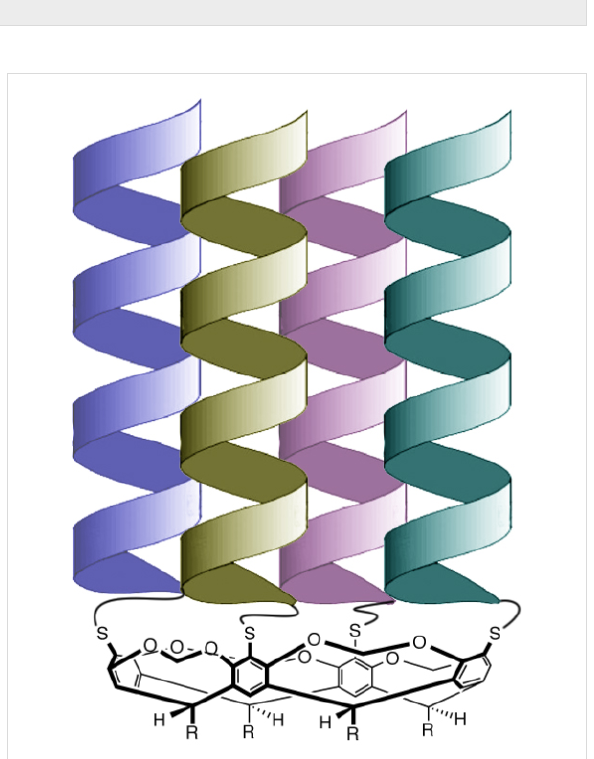
Scheme 4: The carceplex reaction.